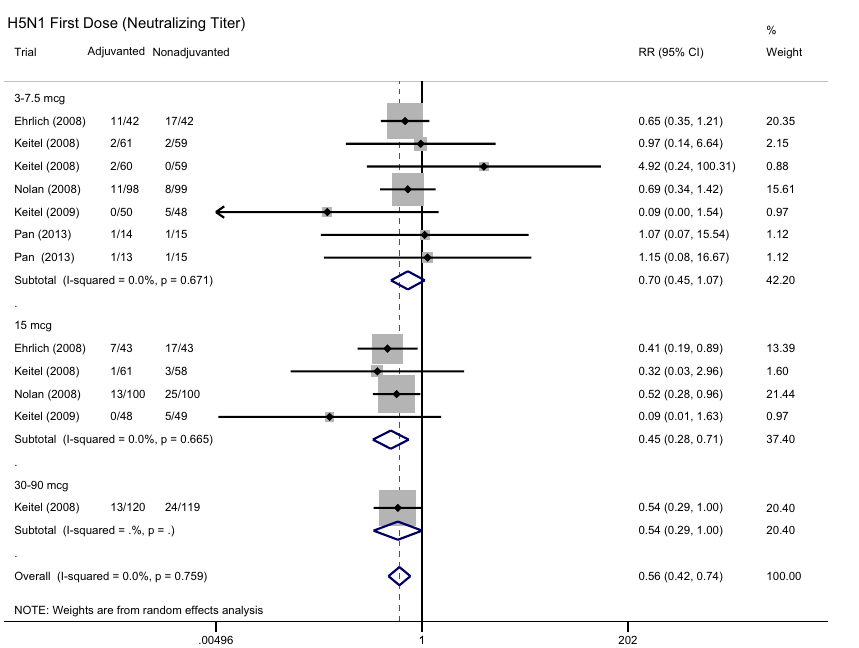
Risk of bias assessment. Three trials, Keitel 12 , Ehrlich 10 , and Chichester 15 , had low risk of bias. Bresson 1 was open-label trial. Pan 16 was single-blind. Three trials, Bresson 1 , Bernstein 9 , and Brady 13 did not reported seroprotection data after the first dose vaccination. Two trials, Nolan 11 and Keitel 14 , did not reported adverse events separately after the first vs. after the second dose. The assessment was summarized in Supplementary Figs S7 and S8.